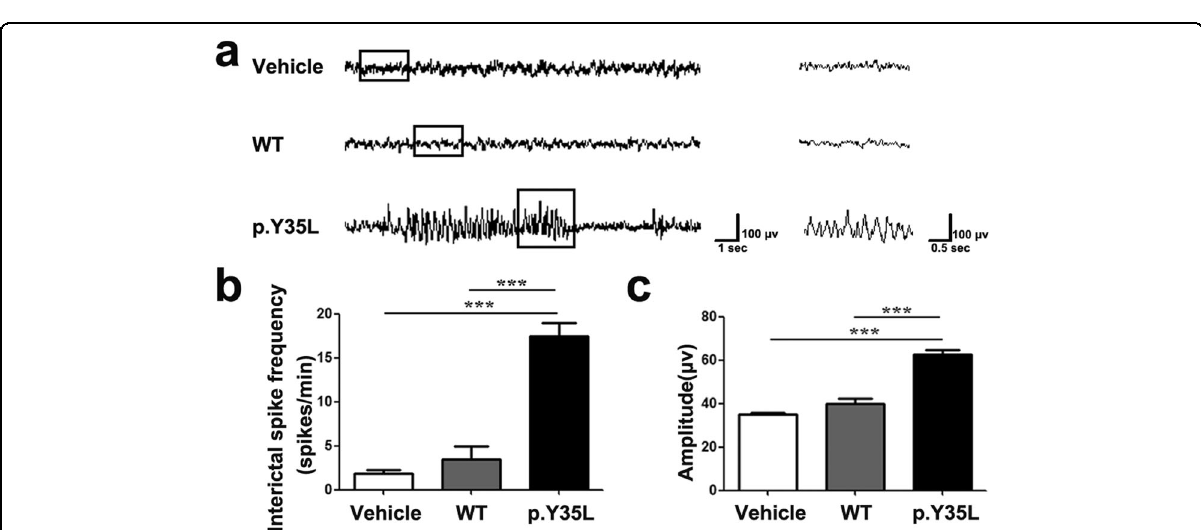
Fig. 4 RHEB p.Y35L mutation induces abnormal EEG in mice. a EEG recordings of mice with embryonic expression of control vehicle, wild-type (WT) or p.Y35L RHEB plasmids. The interictal spike frequency ( b ) and amplitude ( c ) of EEG in a were quanti fi ed for comparison. Data are presented as the mean ± s.e.m. *** P < 0.001 (Vehicle: n = 3, WT: n = 4, p.Y35L: n = 3, one-way ANOVA with Tukey ’ s post test)